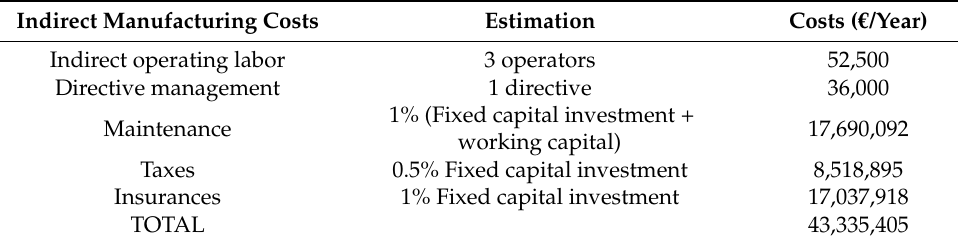
Table 11. Indirect manufacturing